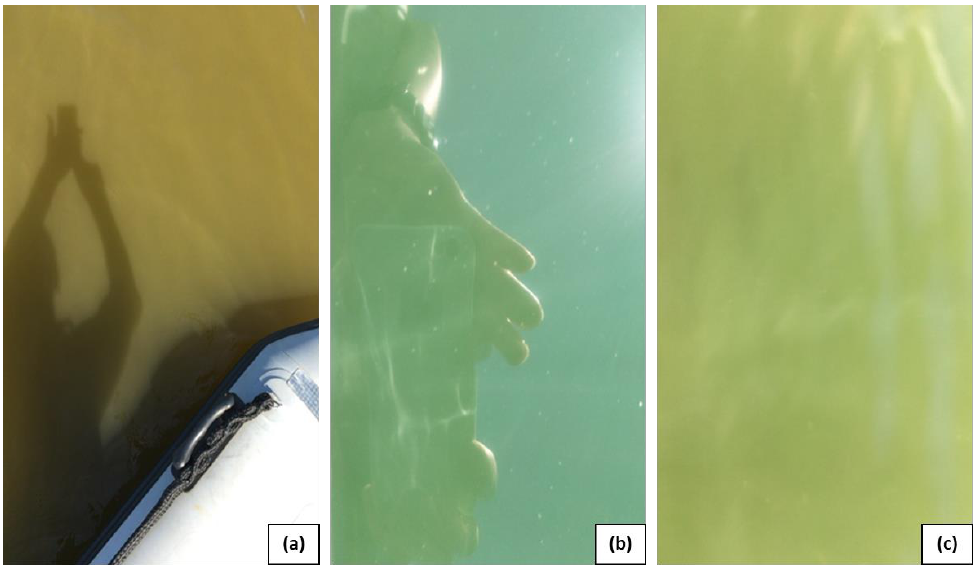
Figure 7. Three examples of images collected with the EoW App: Lake Atkinson ( a ), Lake St Clair station 6 ( b ) and Wivenhoe Dam station 1 ( c ).